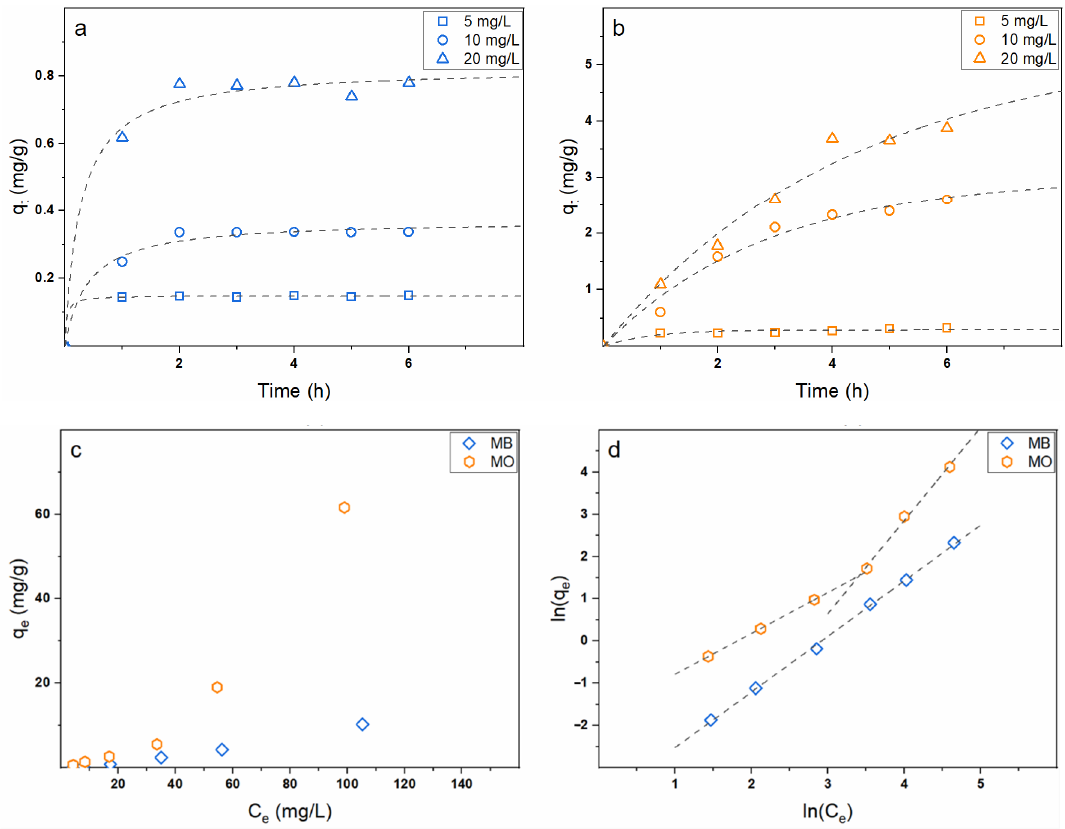
Figure 7. Adsorption kinetics of physically crosslinked chitosan membranes in ( a ) MB and ( b ) MO solutions with different dye concentration (i.e., 5, 10, and 20 mg/L). Data fitting with the pseudo-first-order kinetic model is reported in dashed lines. ( c ) Adsorption isotherm data of physically crosslinked chitosan membranes and ( d ) their fitting with the Freundlich model. q t , q e , and C e represent the adsorption capacity at a certain time t, the adsorption capacity at equilibrium, and the dye solution equilibrium concentration, respectively.